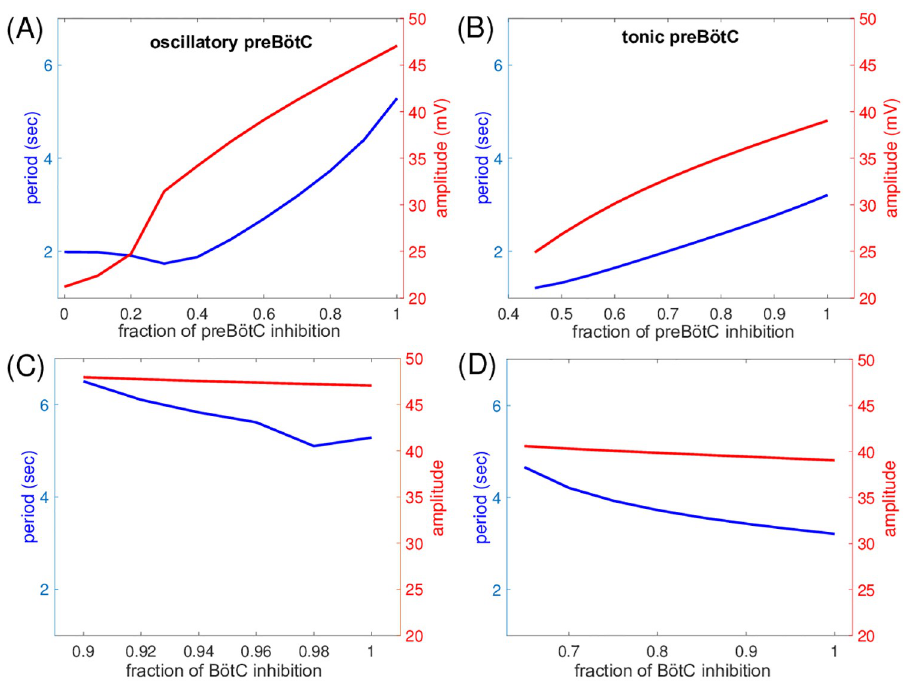
Fig 10. Dependence of respiratory period and amplitude of inspiratory signal on inhibition levels. (A) pre-I unit is intrinsically oscillatory ( c 11 = − 0.03) and inhibition to the preBo¨tC units (pre-I and early-I) is varied. (B) pre-I unit is intrinsically tonic ( c 11 = 0.01) and inhibition to the preBo¨tC units (pre-I and early-I) is varied. (C) pre-I unit is intrinsically oscillatory ( c 11 = − 0.03) and inhibition to the Bo¨tC units (post-I and aug-E) is varied. (D) pre-I unit is intrinsically tonic ( c 11 = 0.01) and inhibition to the Bo¨tC units (post-I and aug-E) is varied. All horizontal axis ranges are distinct; in all cases, the baseline network corresponds to 1 and the lower bound denotes a level just below which the oscillation is lost. The network response to lowered inhibition is qualitatively similar regardless of whether the pre- I unit is oscillatory or tonic. Period and amplitude are both much more strongly modulated by changes in inhibition to the preBo¨tC units than by changes in inhibition to the Bo¨tC units; note also that the slopes of the period curves are opposite in the two cases.